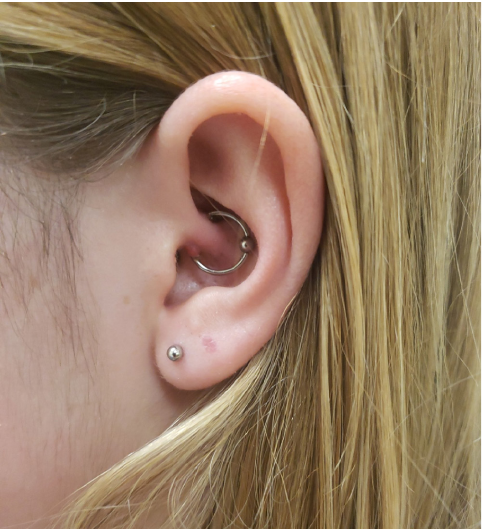
Figure 1. Daith piercing (with permission of the patient and her mother), showing the piercing through the crus helix.